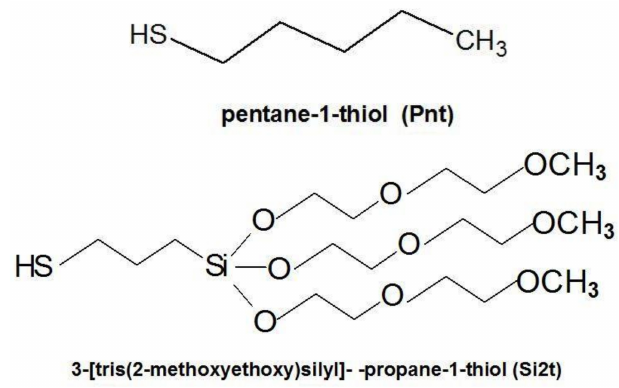
Figure 2. The structure of main alkanethiols